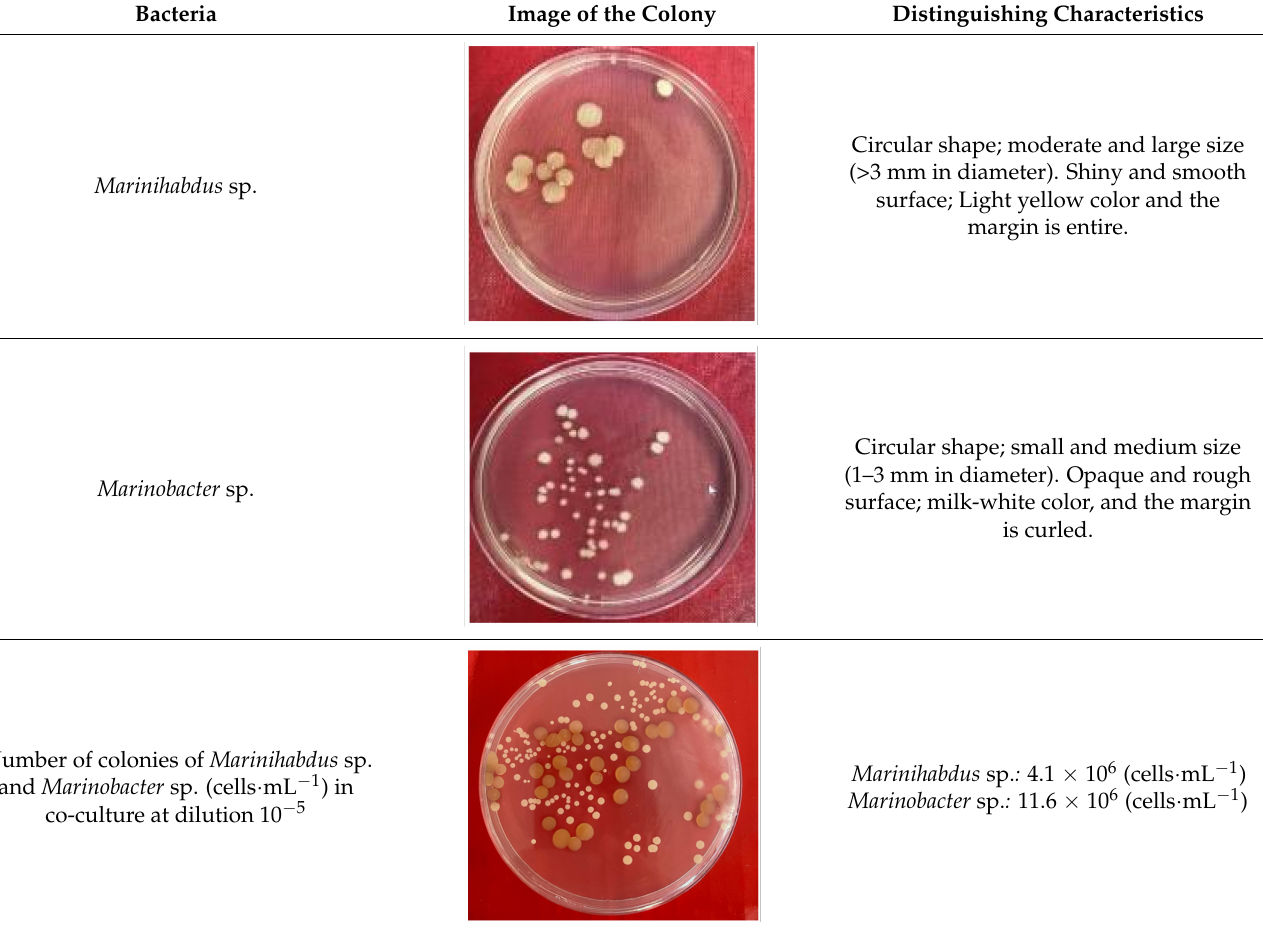
Number of colonies of Marinihabdus sp. and Marinobacter sp. (cells · mL − 1 ) in co-culture at dilution 10 −